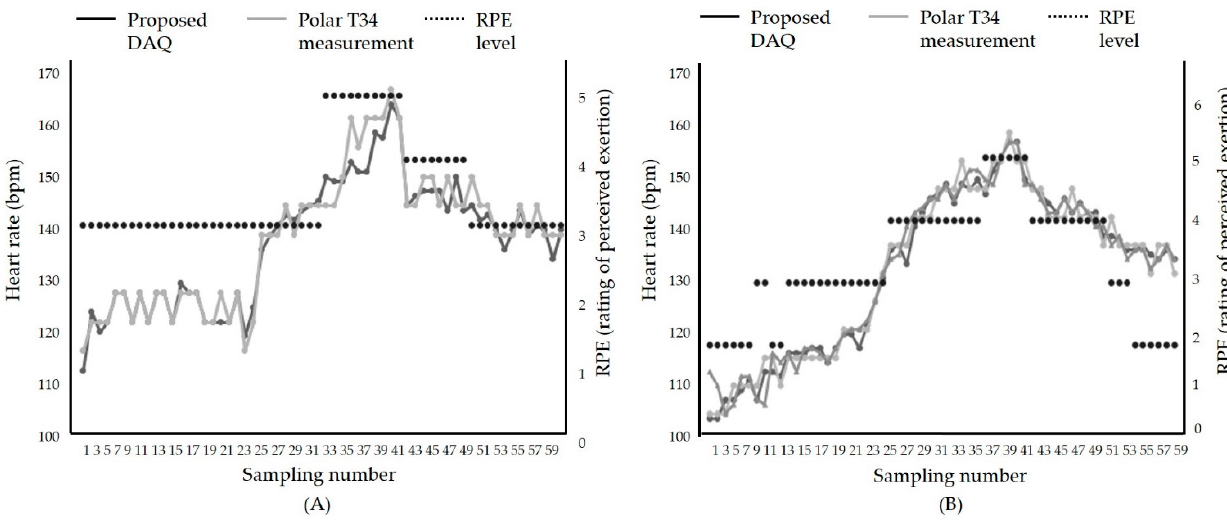
Figure 10. Comparison results between the heart rate during exercise using; ( A ) Treadmill, ( B ) stationary bike.